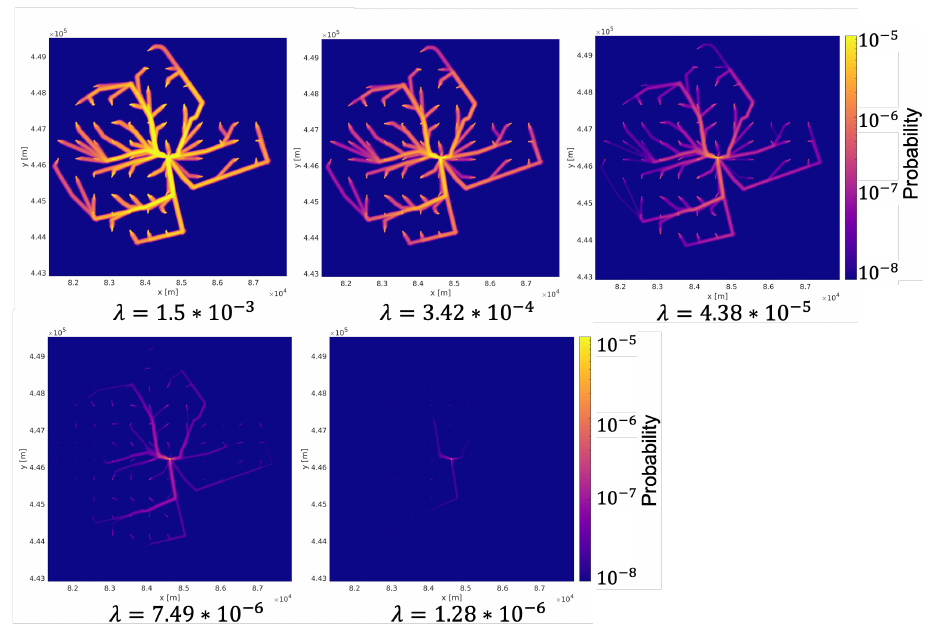
Figure A5. Annual IR with different failure rate λ .